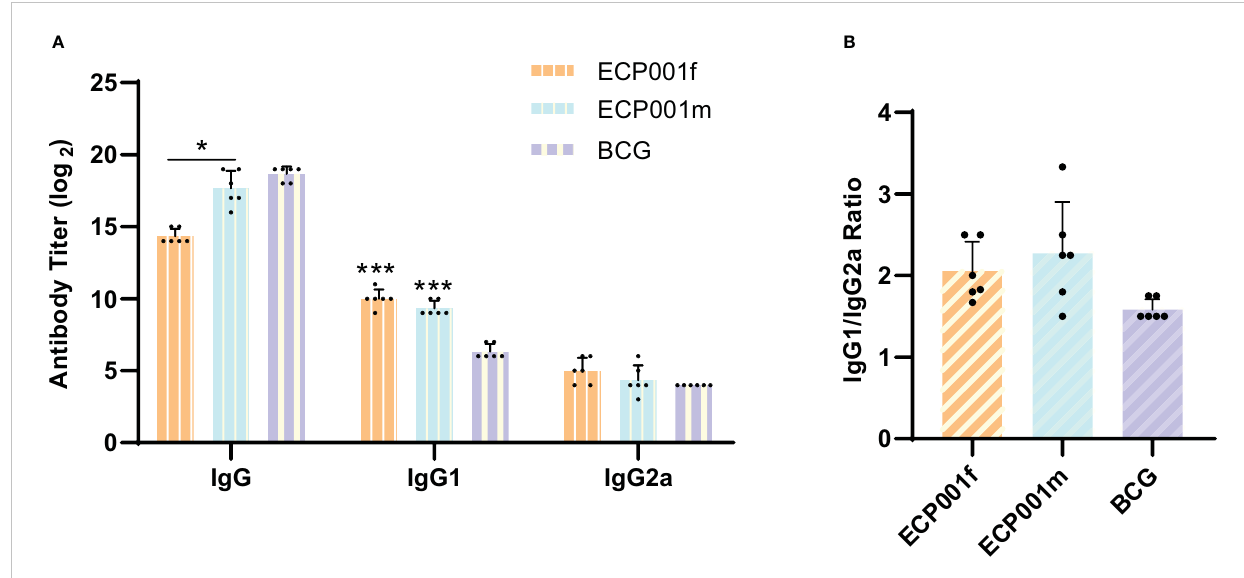
FIGURE 4 Determination of IgG, IgG1 and IgG2a subtypes in serum of BALB/C mice immunized with ECP001f, ECP001m and BCG groups. (A) the antibody titers of ECP001f and ECP001m groups were compared with those of BCG group. (B) the ratio of IgG1 to IgG2a in ECP001f and ECP001m groups was compared with that in BCG group. The signi fi cant difference between ECP001f, ECP001m group and BCG group was indicated by the asterisk above the antigen column, and the signi fi cant difference between ECP001f group and ECP001m group was indicated by the asterisk above the line between the two groups. (*P<0.05,